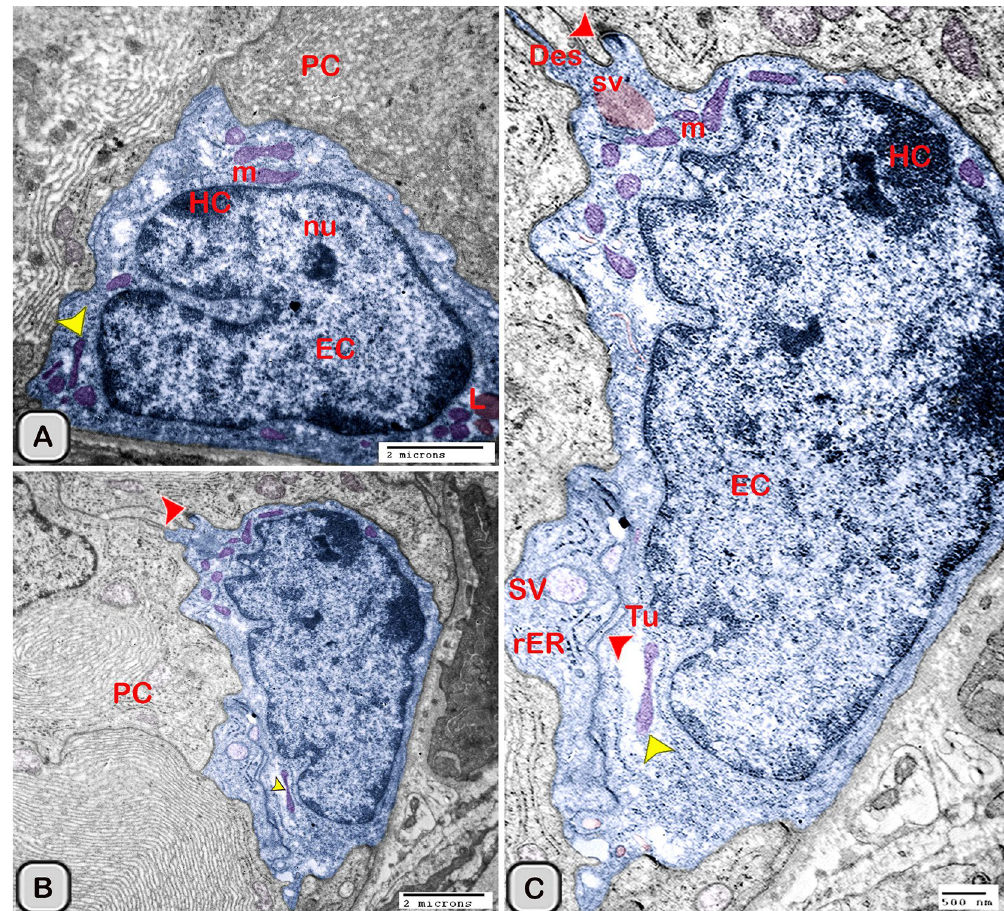
Figure 14. Digitally colored transmission electron microscope images of the activated DCs in the melatonin treated group. (A,B) An active polyhedral and triangular shaped dendritic cell with abundant cell organelles and euchromatic nucleus (Ec) with a distinct nucleolus (nu) were investigated. (C) Higher magnification showing abundant mitochondria (m), rER, secretory vesicles (Sv), tubules (Tu), lysosomes (L) and Birbeck granules (yellow arrowheads). Moreover, the cell processes were thin and short and desmosomal junctions (Des, red arrowheads) were